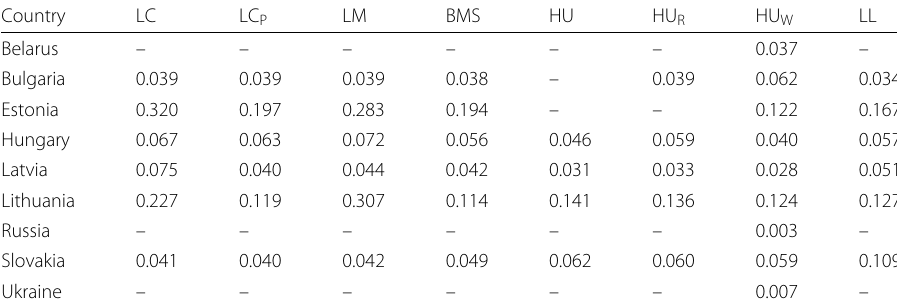
Table 7 One-step-ahead forecast bias of the fitted models in terms of MSE considering harmonized fitting